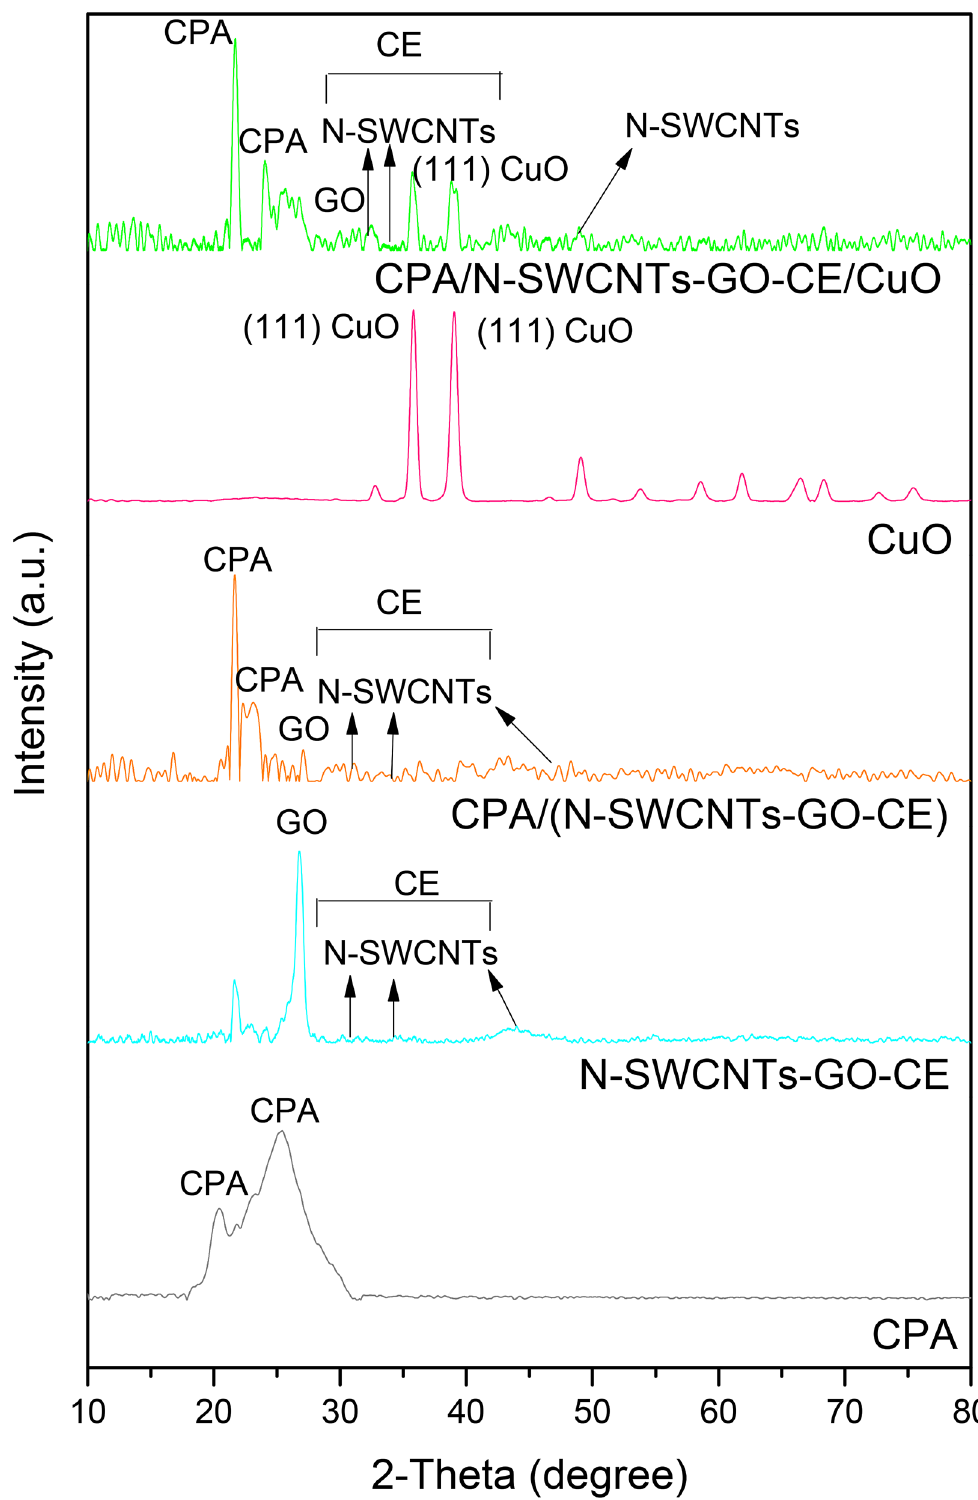
Figure 6. XRD diffraction patterns for pure CPA, N-SWCNTs-GO-CE, CPA/N-SWCNTs-GO-CE, CuO, and CPA/N-SWCNTs-GO-CE/CuO